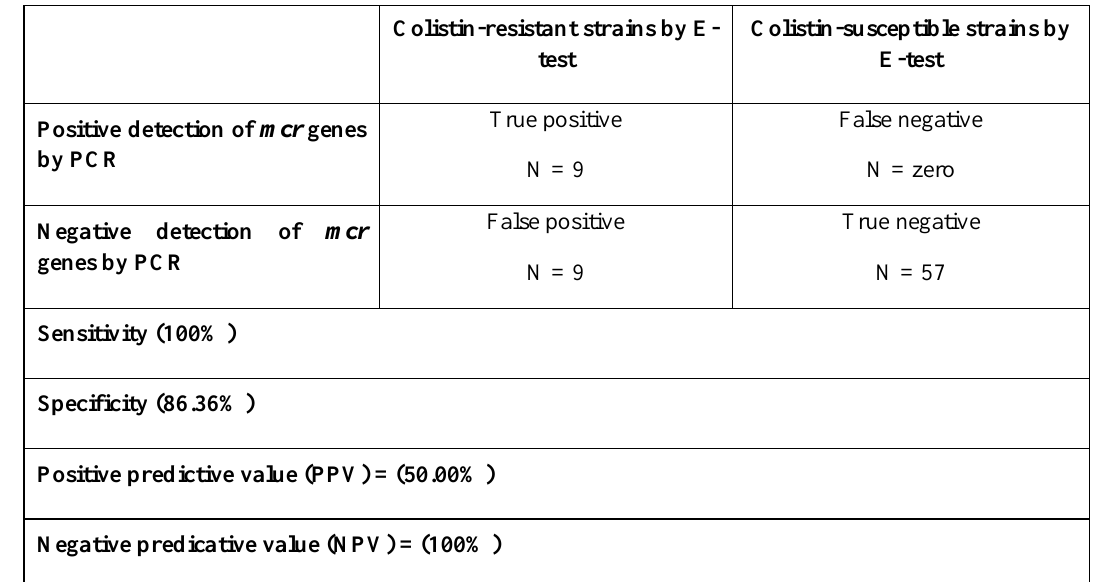
Table 9. Comparison between E- test and molecular method (PCR) regarding the detection of colistin resistance